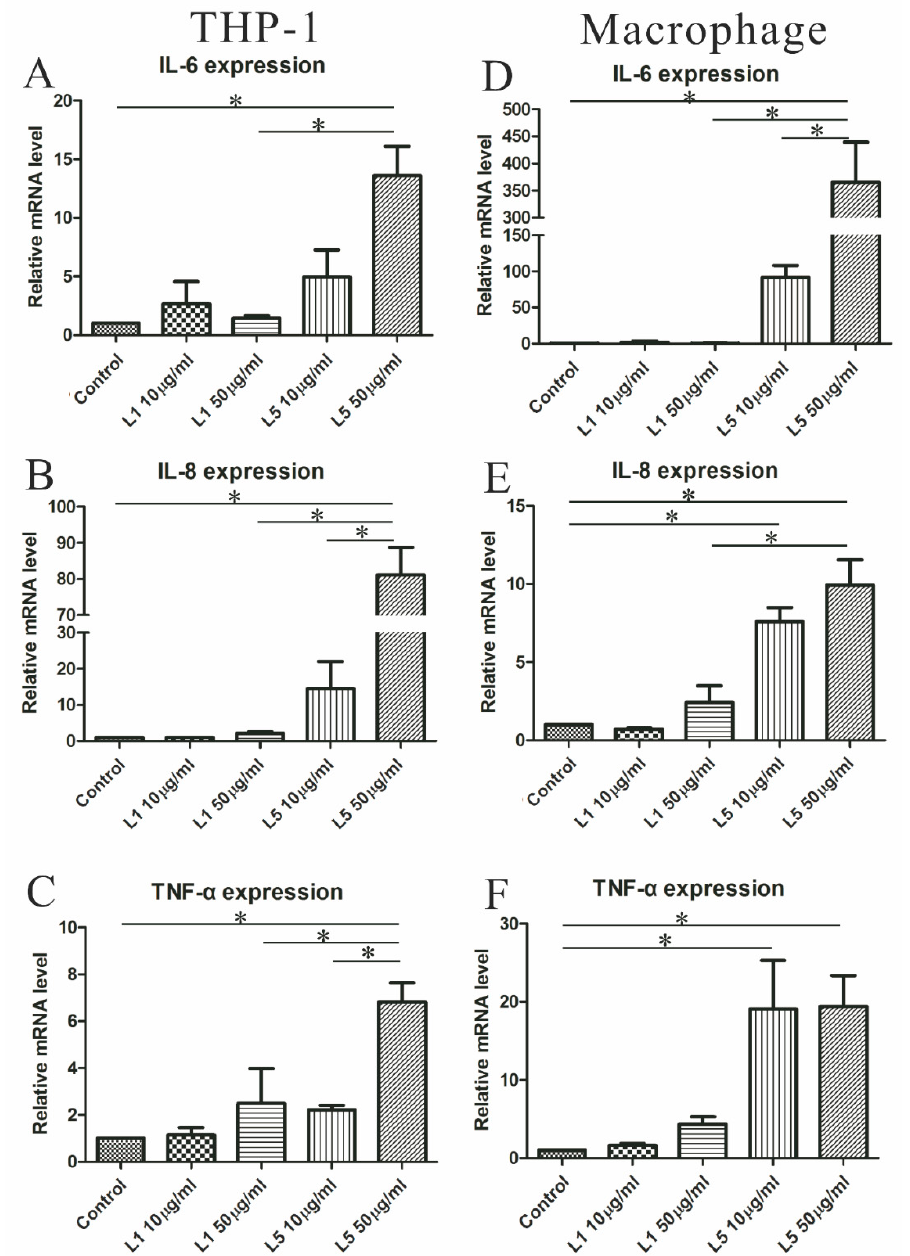
Figure 3. E ff ects of L5 on the expression of cytokines in monocytes and macrophages. The di ff erences in the mRNA expression levels are shown for IL-6 ( A ), IL-8 ( B ), and ( C ) tumor necrosis factor- α (TNF- α ) in THP-1 cells (human monocytic cell line) treated with di ff erent doses of L1 and L5. The di ff erences in the mRNA expression levels are shown for IL-6 ( D ), IL-8 ( E ), and ( F ) TNF- α in THP-1 cells-derived macrophages treated with di ff erent doses of L1 and L5. Data are the mean ± SEM for three independent experiments. * p < 0.05.